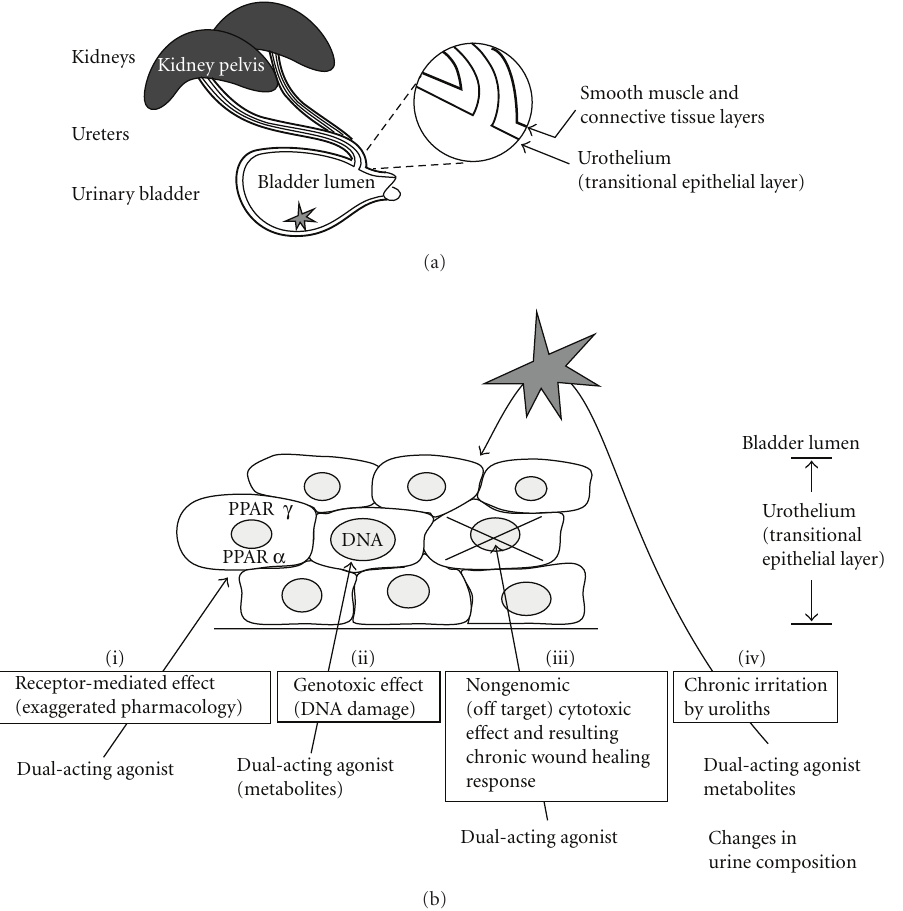
Figure 1: Possible mechanisms for the carcinogenic e ff ect of dual-acting PPAR α + γ agonists in the rat urothelium. (a) Simplified view of the rat urinary tract, showing the urothelial lining of urinary bladder, ureters, and kidney pelvis. The star in the bladder lumen indicates the expected predilection site for urolith residence, the ventral part of the bladder. In the shown part of the urogenital tract, there are no gross anatomical di ff erences between male and female rats. The epithelial lining is contiguous but exhibits di ff erentiation di ff erences through the urogenital tract [58, 59]. The drawing is not to scale. (b) Four possible mechanisms for carcinogenic e ff ect in rat urothelium by dual-acting PPAR α + γ